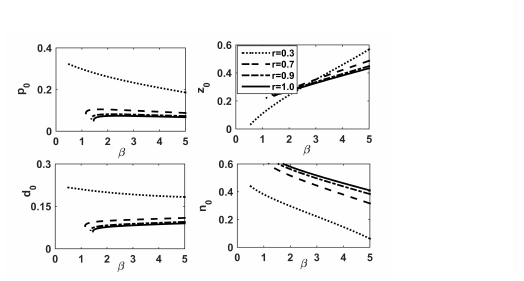
Figure 4. Due to perturbations, biomass of each components of NPZD system changes, however, a significant increase in Z-biomass is evident. Another bifurcation diagram with respect to parameter r (Z- grazing rate) at di ff erent perturbations values showing variations in ecosystems components